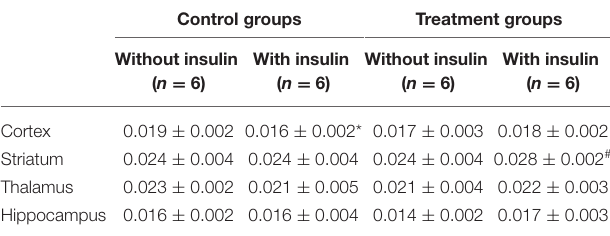
TABLE 2 | 18 F-FDG accumulation in brain regions in mice